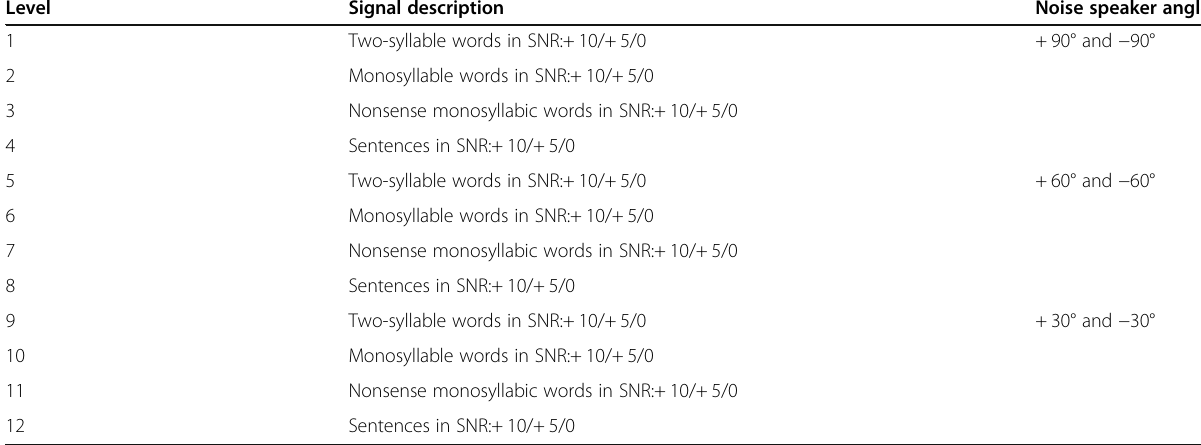
Table 1 The level of auditory training difficulty: all these levels were presented at first by narrow-band noise and then all these steps repeated for babble noise